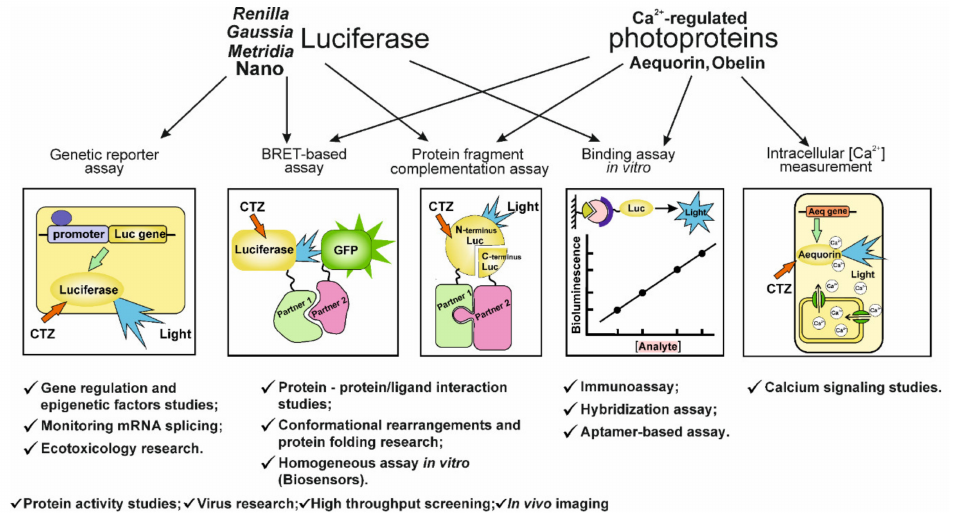
Figure 7. Main principles on the basis of which analytical methods and investigations can be carried